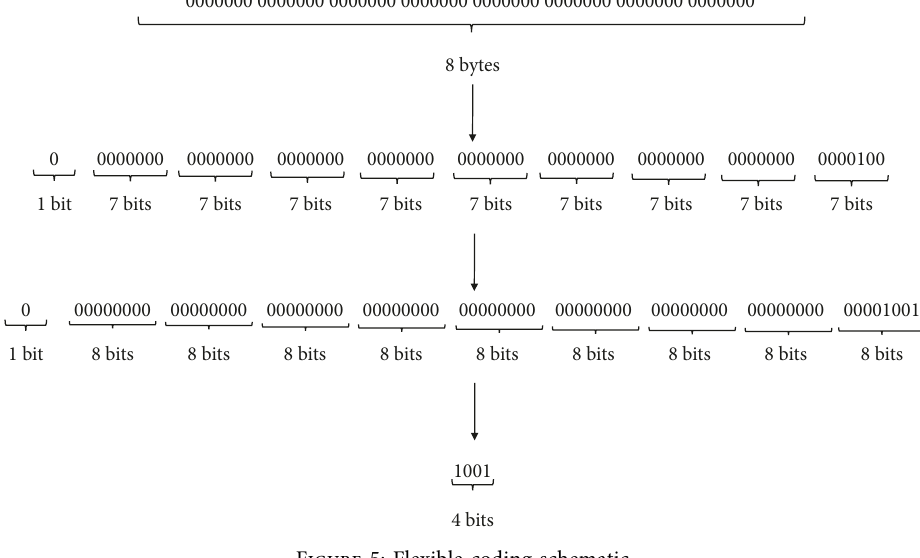
Figure 5: Flexible coding